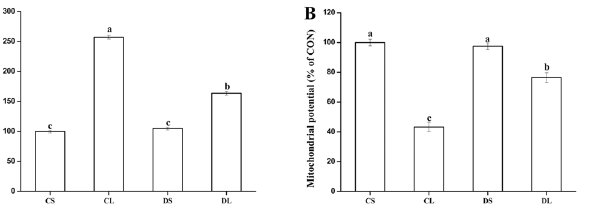
Fig 6. Effects of DMG-Na on ROS concentrations (A) and mitochondrial membrane potential (B) in LPS-injected mice liver. In panels A and B, the value of CS group is set to 100%. Values are mean ± SEMs (n = 10). Mean of a variable without a common letter differ, P < 0.05. Reactive oxygen species (ROS). CS, gastric intubation in mice with 0 mg DMG-Na/0.3 ml sterile saline solution for 28 days and intraperitoneal injection with 100 μ g/kg body weight of sterile saline solution at 29 day; CL, gastric intubation in mice with 0 mg DMG-Na/0.3 ml sterile saline solution for 28 days and intraperitoneal injection with 100 μ g/kg body weight of LPS at 29 day; DS, gastric intubation in mice with 12 mg DMG-Na/0.3 ml sterile saline solution for 28 days and intraperitoneal injection with 100 μ g/kg body weight of sterile saline solution at 29 day; DL, gastric intubation in mice with 12 mg DMG-Na/0.3 ml sterile saline solution for 28 days and intraperitoneal injection with 100 μ g/kg body weight of LPS at 29 day.